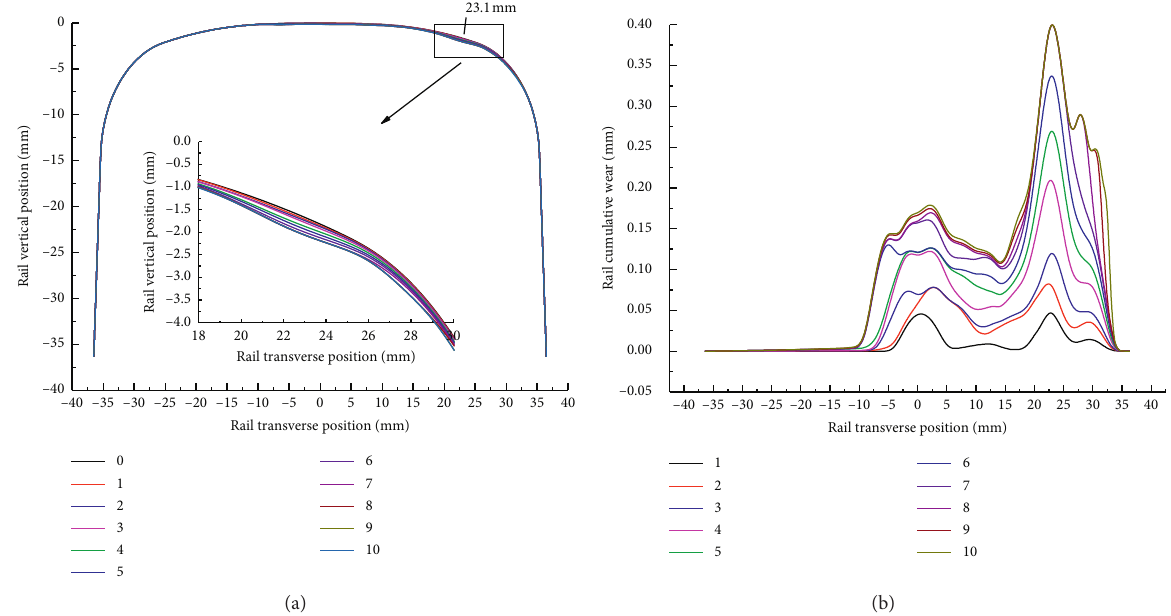
Figure 7: Outer rail. (a) Profile contrast diagram. (b) Cumulative wear contrast diagram.